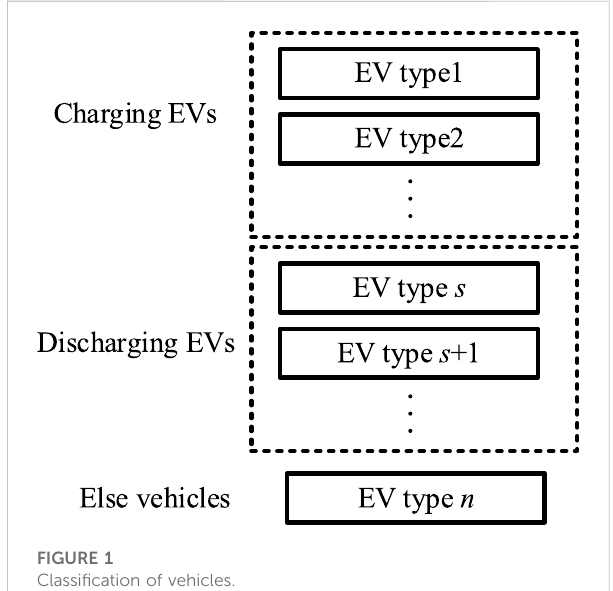
FIGURE 1 Classi fi cation of